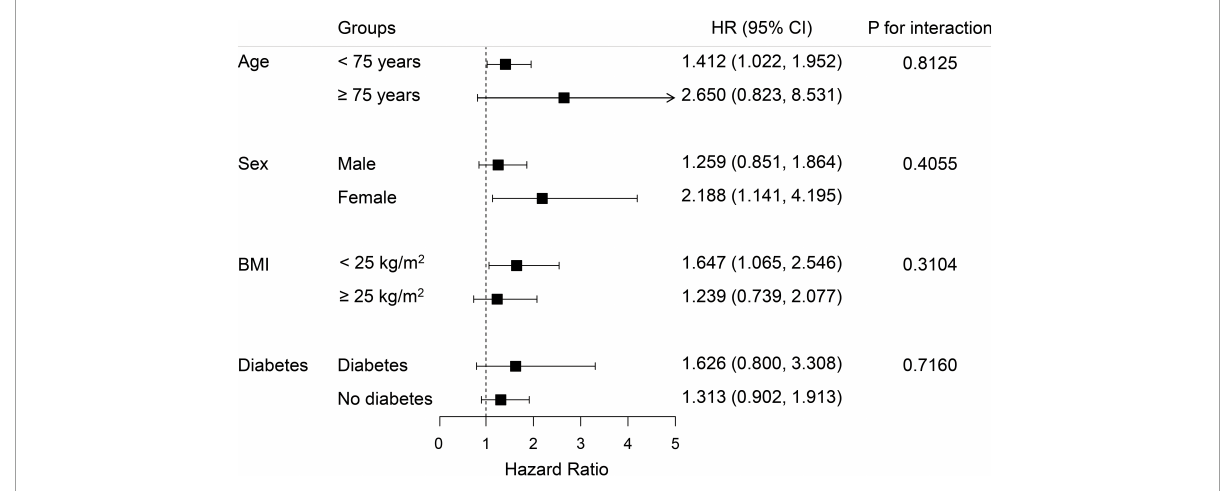
FIGURE4 The subgroup analysis of the association between NT-proBNP level and MACE risk according to age, sex, BMI, and diabetes. Adjusted for age, sex, BMI, smoking status, prior history of diabetes, hypertension, LVEF, plasma level of hsCRP, endothelin HbA1C, and Free